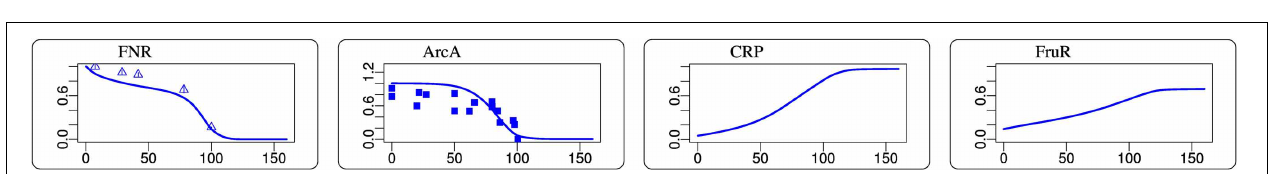
FIGURE 4 | Steady-state simulation results of some transcription factor activities in comparison to measurement data. The abscissa is aerobiosis in percent. The ordinate is in arbitrary units. FNR data from Rolfe et al. (2011). ArcA data was determined as described in Rolfe et al. (2012).